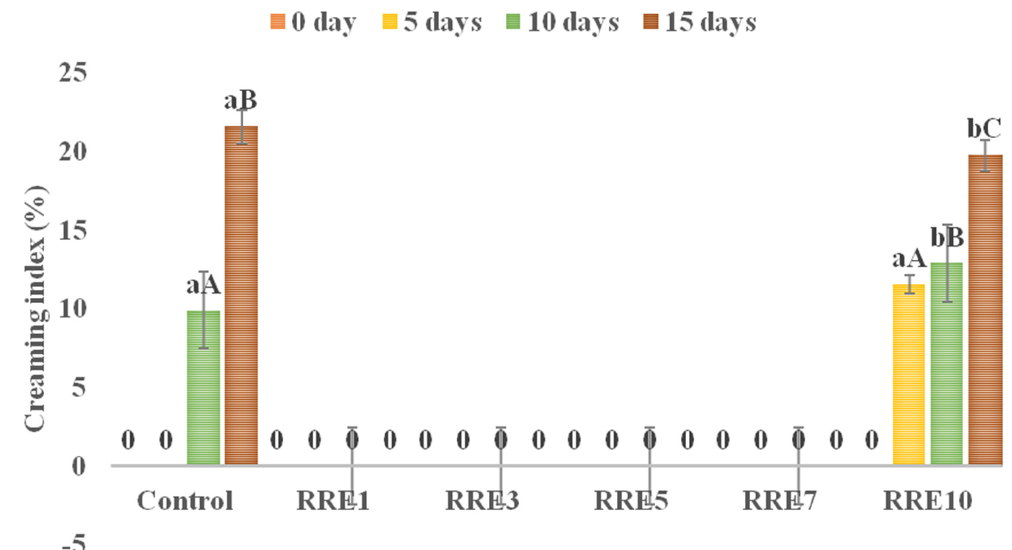
Figure 2. Creaming index of control and RRE nanoemulsions during storage of 15 days. Data are presented as means ± SD ( n = 3). a–b Means within the column with different lowercase superscripts are significantly different ( p < 0.05) from each other. A–C Means within the column with different uppercase superscripts are significantly different ( p < 0.05) from each other.